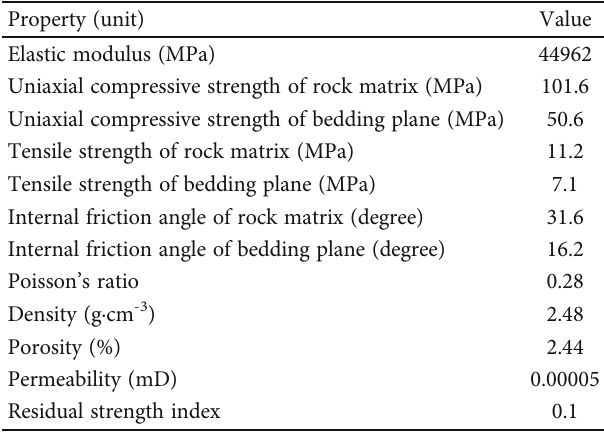
Table 1: Macro input parameters of model.